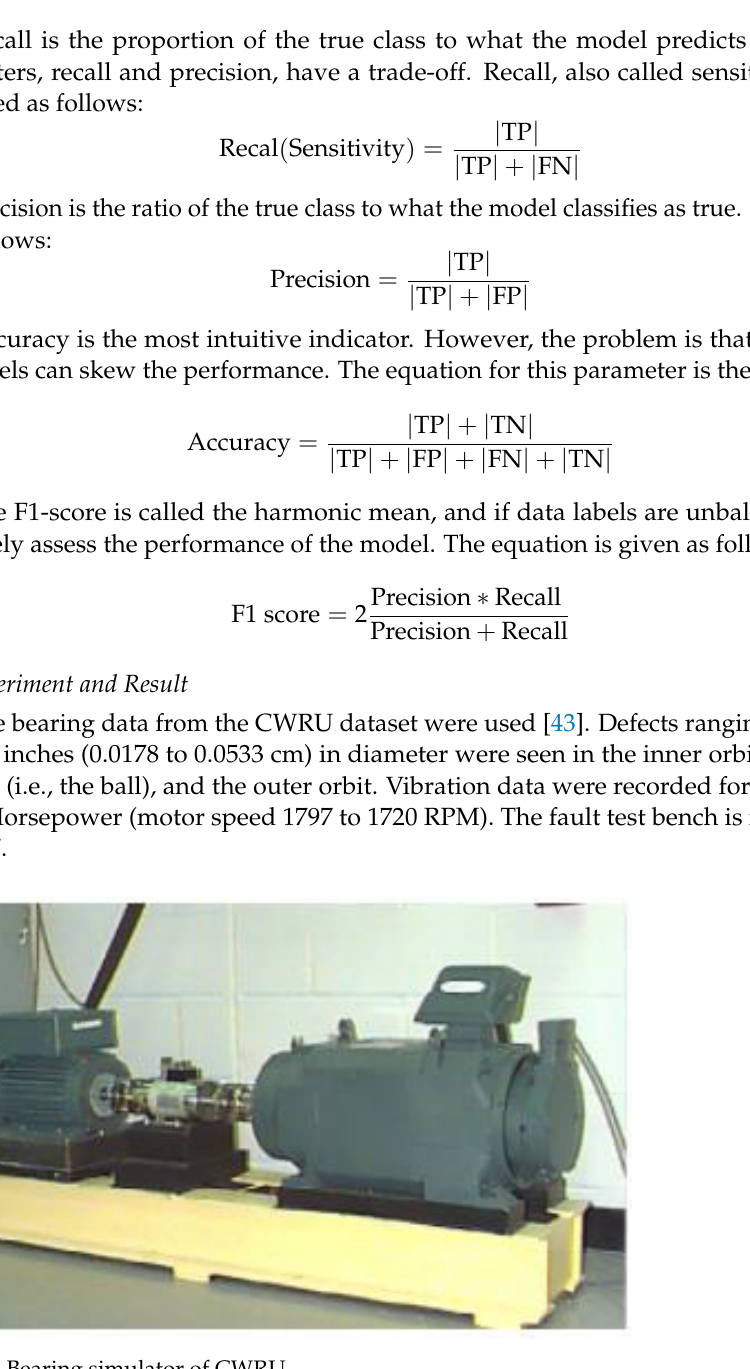
Table 4. Description of CWRU data.